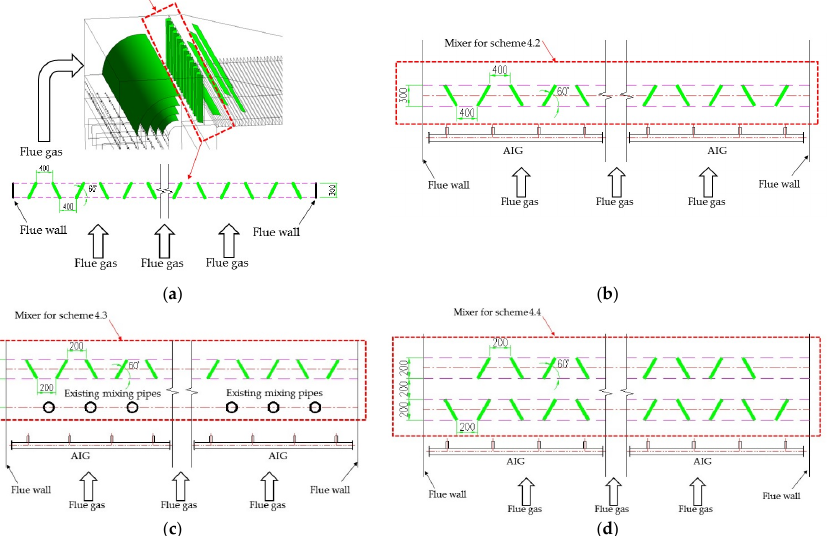
Figure 4. Arrangement schemes for different ammonia flue gas mixers: ( a ) Scheme 4.1; ( b ) Scheme 4.2; ( c ) Scheme 4.3; ( d ) Scheme 4.4.